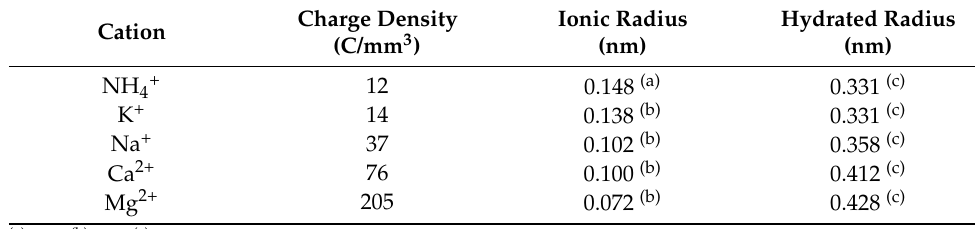
Charge Density (C/mm 3 )